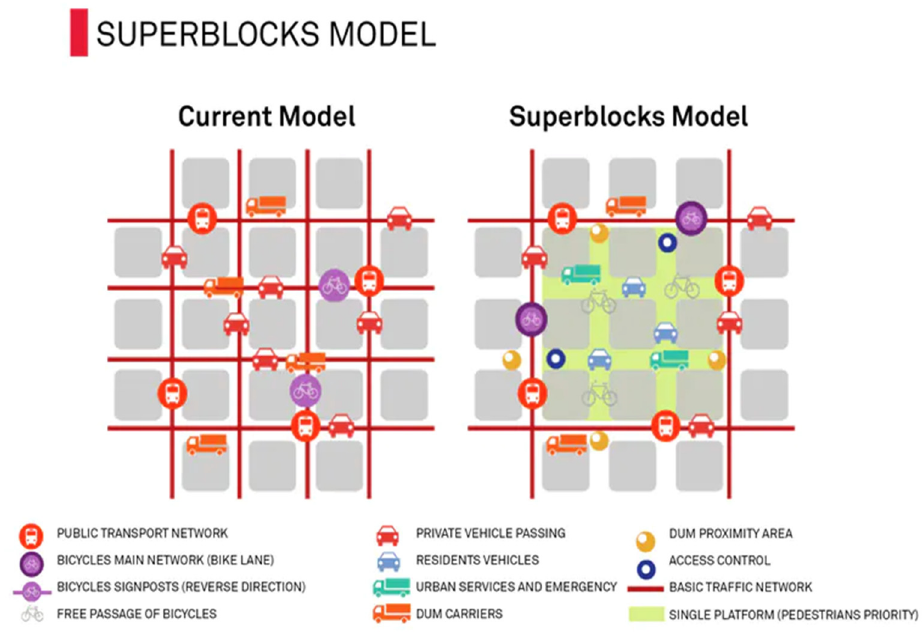
Figure 1. Differences between the single use model of urban mobility and the Superblock model. Source: Reproduced from [15].